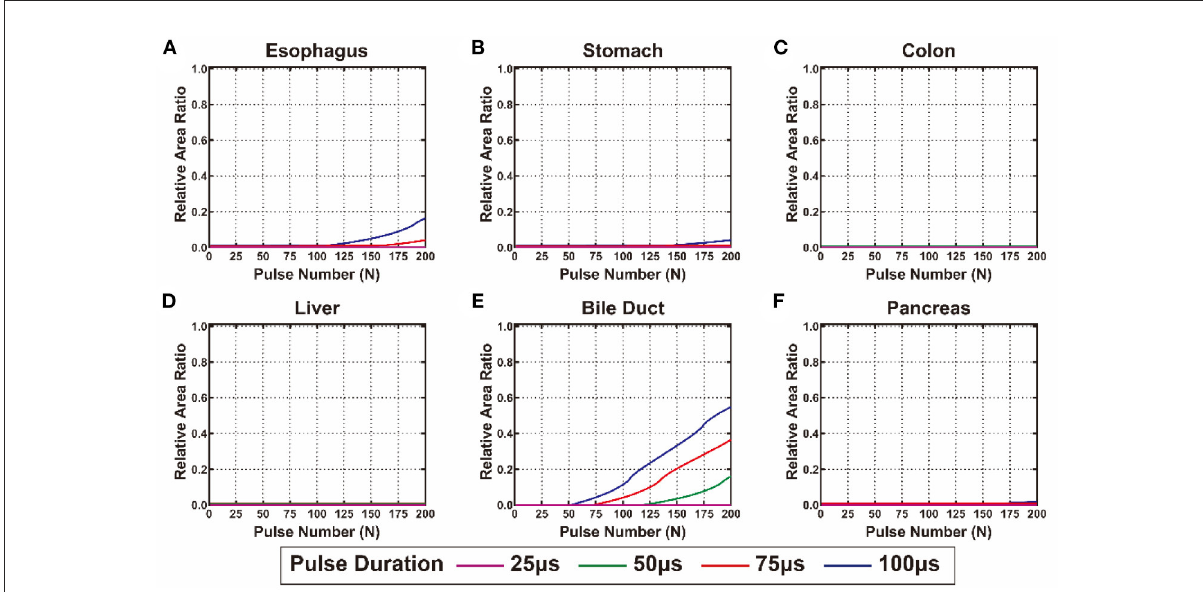
FIGURE5 The calculated relative area ratio of the thermal injury to the digestive system. (A) Esophagus, (B) pancreas, (C) stomach, (D) colon, (E) liver, and (F) bile duct.